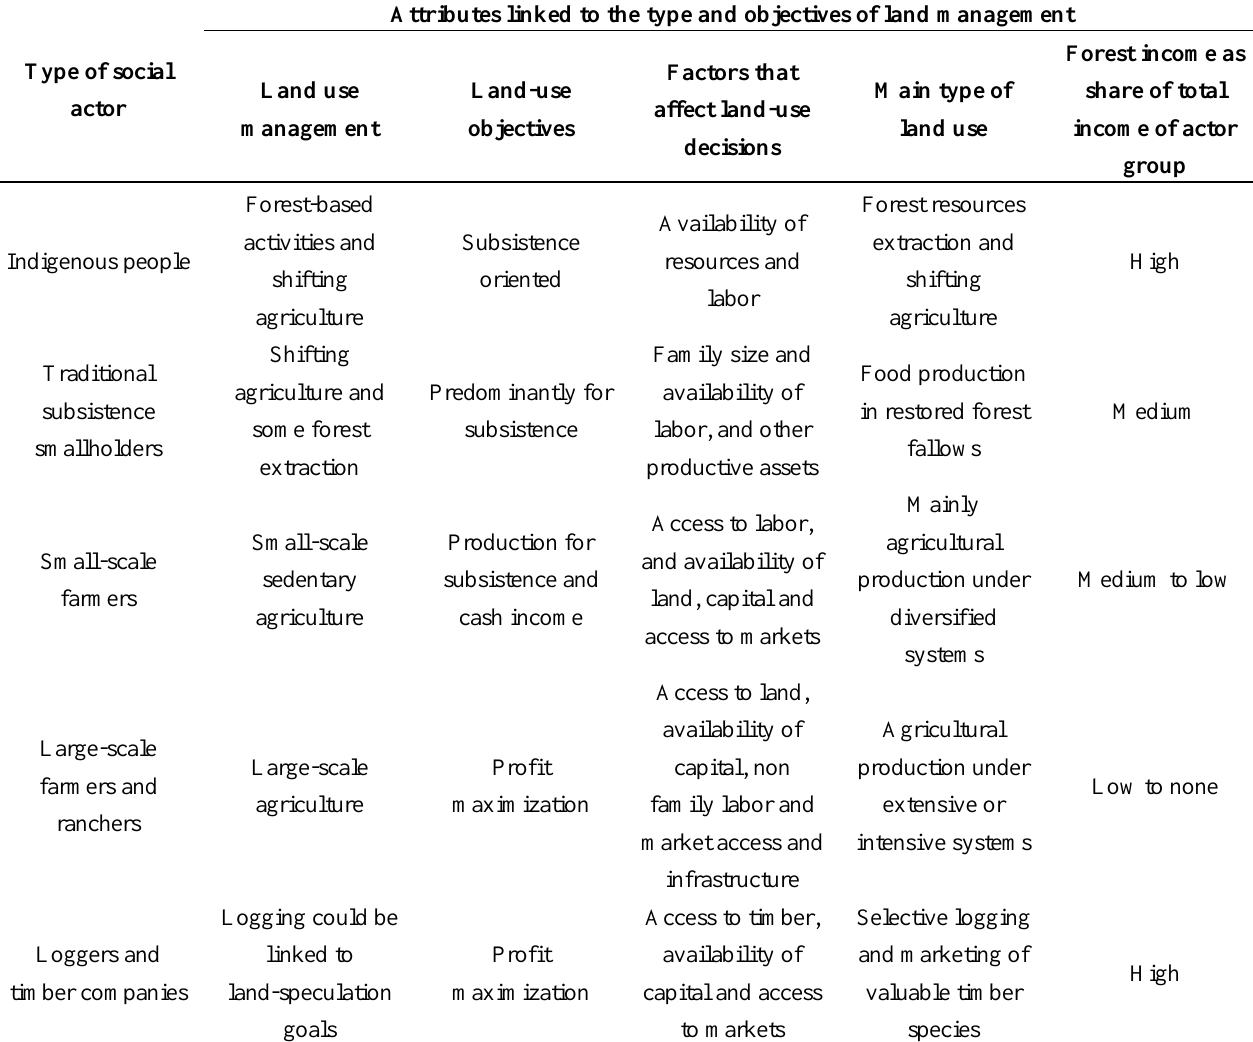
Table 1. Types of forest-based livelihoods and associated attributes of forest